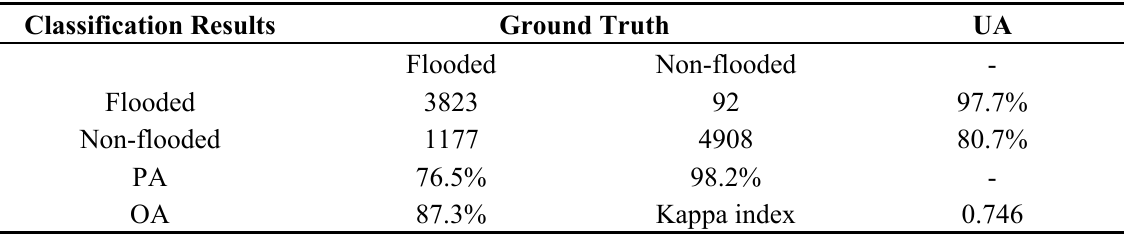
Table 3. Confusion matrix for RGB +